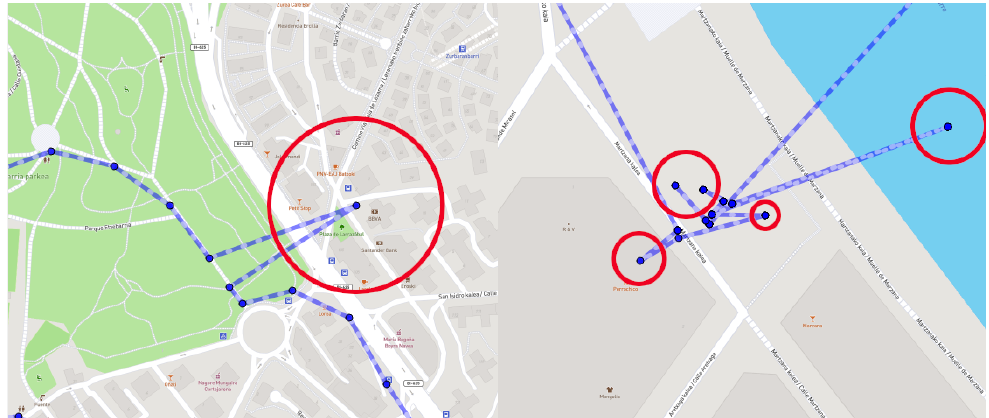
Figure 3. Examples of motion-related GPS drift ( left ) and static-related GPS drifts ( right ). 3.